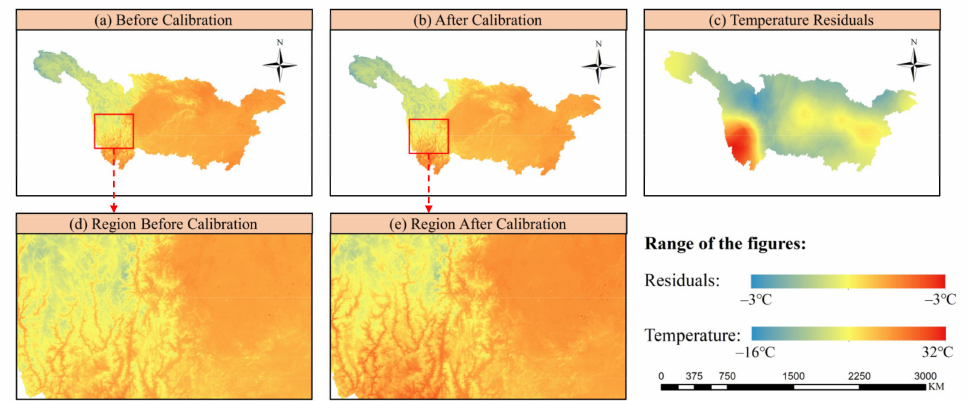
Figure 11. The spatial distribution of downscaled temperature before ( a ) and after ( b ) bias calibration. ( c ) is the distribution of residuals between downscaled temperature and in-situ observations. ( d , e ) are the regions with significant changes before and after